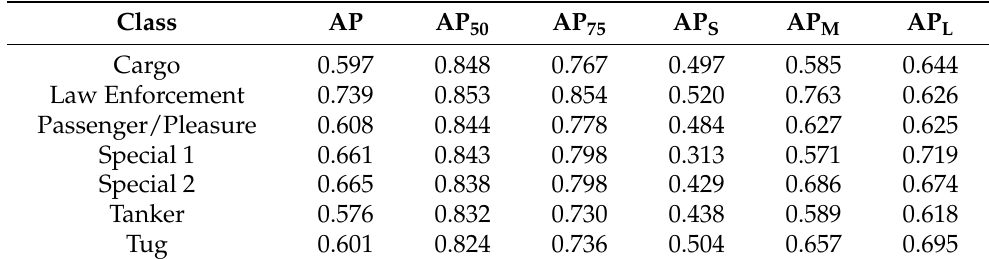
Table A5. Resulting instance segmentation APs per class of the ShipSG dataset using Centermask- Lite V19 , as explained in Section 3.1.